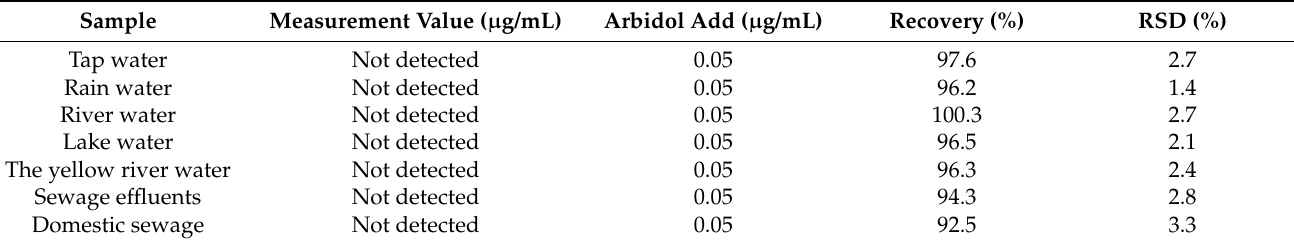
Table 4. The recovery of arbidol from real water